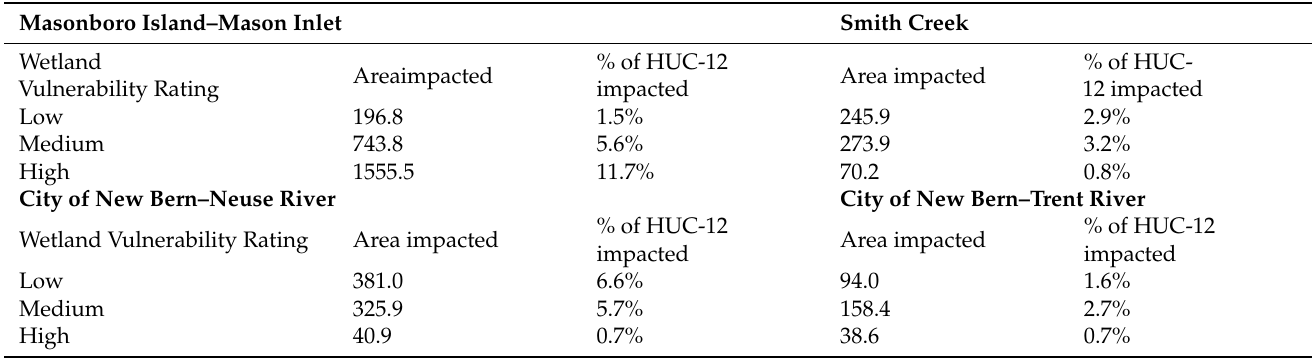
Table 4. Combined wetland vulnerability assessment metrics for the four study areas in acres and as a percentage of the HUC-12